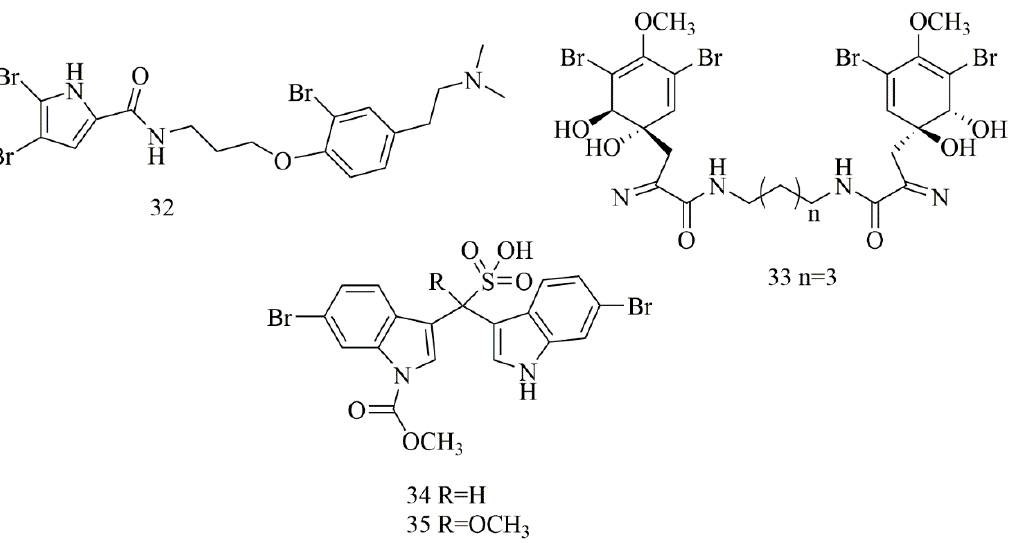
Figure 4. Dibrominated and brominated alkaloids from marine sponges. Table 4. Cytotoxic activity of dibrominated and brominated alkaloids from sponges.